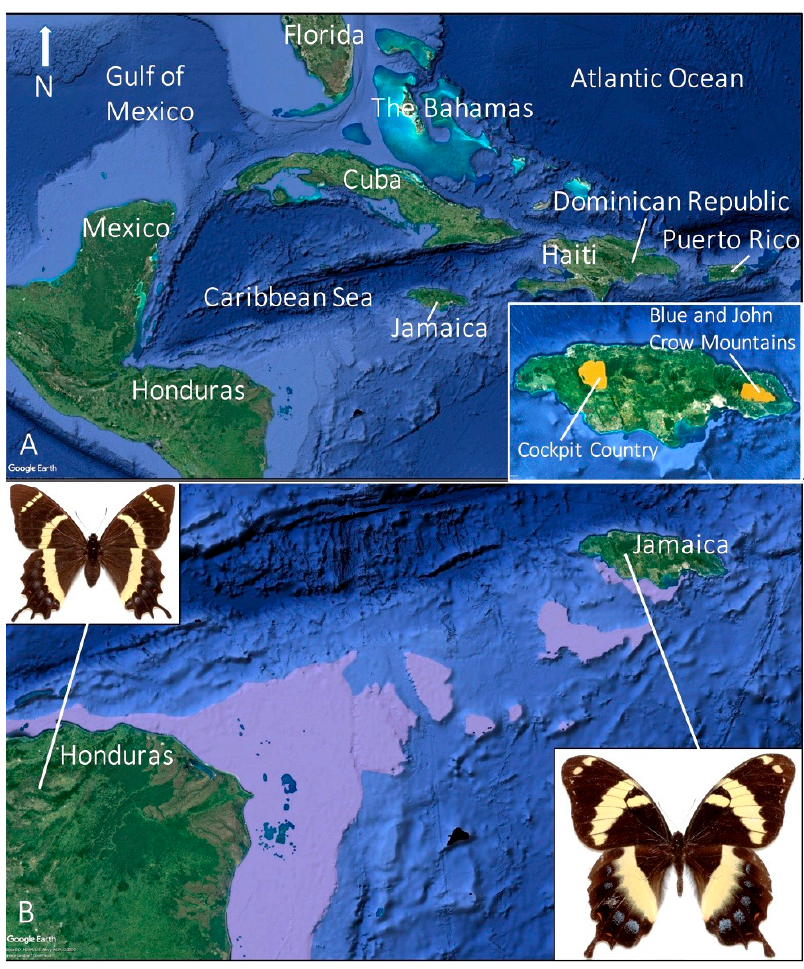
Figure 5. Maps of Central America and the Caribbean showing the distribution of Papilio homerus . ( A ) Map showing the location of Jamaica relative to the other Caribbean islands and Central America. The inset (bottom right) shows the range of the extant P. homerus populations (yellow) in the Cockpit Country and the Blue and John Crow Mountains, Jamaica. ( B ) Papilio garamas (from Honduras and other regions of Central America, top left image) and P. homerus (only found in Jamaica, bottom right) putatively share a recent common ancestor. Fluctuations in the sea level might have extended the mainland of Central America and created islands in the past (areas shown in purple) that would have acted as stepping stones for the common ancestors of P. garamas and P. homerus to move to Jamaica and speciate. Shown here is a female of P. garamas electryon Bates 1864 captured from El Salvador in 1969. All maps were acquired from Google Earth ® .